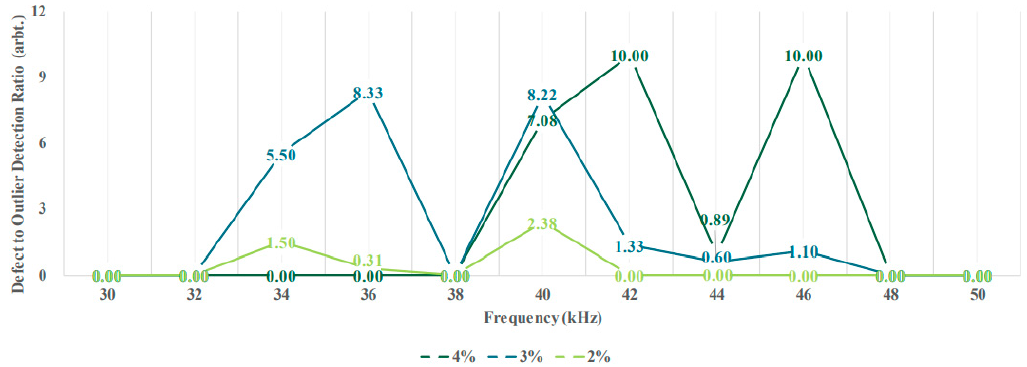
Figure 20. The ratio of detection amplitude of defect to outliers. In cases where the defect is not detected, the ratio is set as zero.